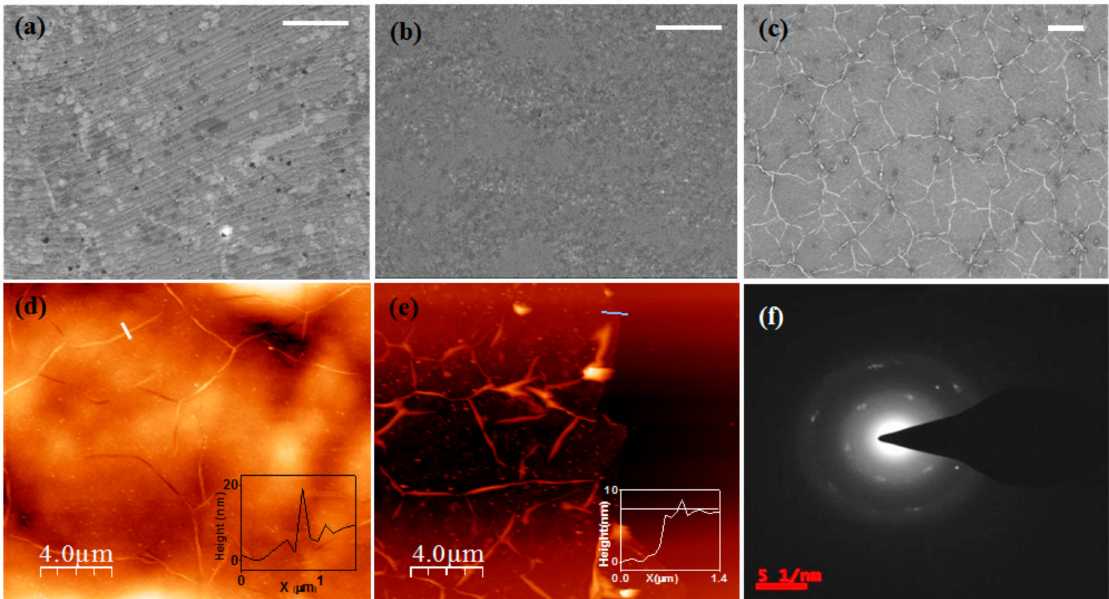
Figure 1. Field Emission Scanning Electron Microscopy (FESEM) and Atomic Force Microscopy (AFM) studies of the as-synthesized film. ( a – c ) FESEM images of the hexagonal Boron Nitride (hBN) film over a Cu substrate of 1.5, 6, and 7 nm film. Scale bar − 2 µ m ( a , b ), 5 µ m for ( c ). ( d ) AFM micrograph of the 7 nm film over copper substrate, Inset—Height profile of the wrinkle. ( e ) AFM image of the transferred 7 nm film (the mean height of the film is 7 nm), Inset—Height profile. ( f ) Selected area electron diffraction (SAED) pattern of the film (6 nm) at 200 kV, depicting polycrystalline